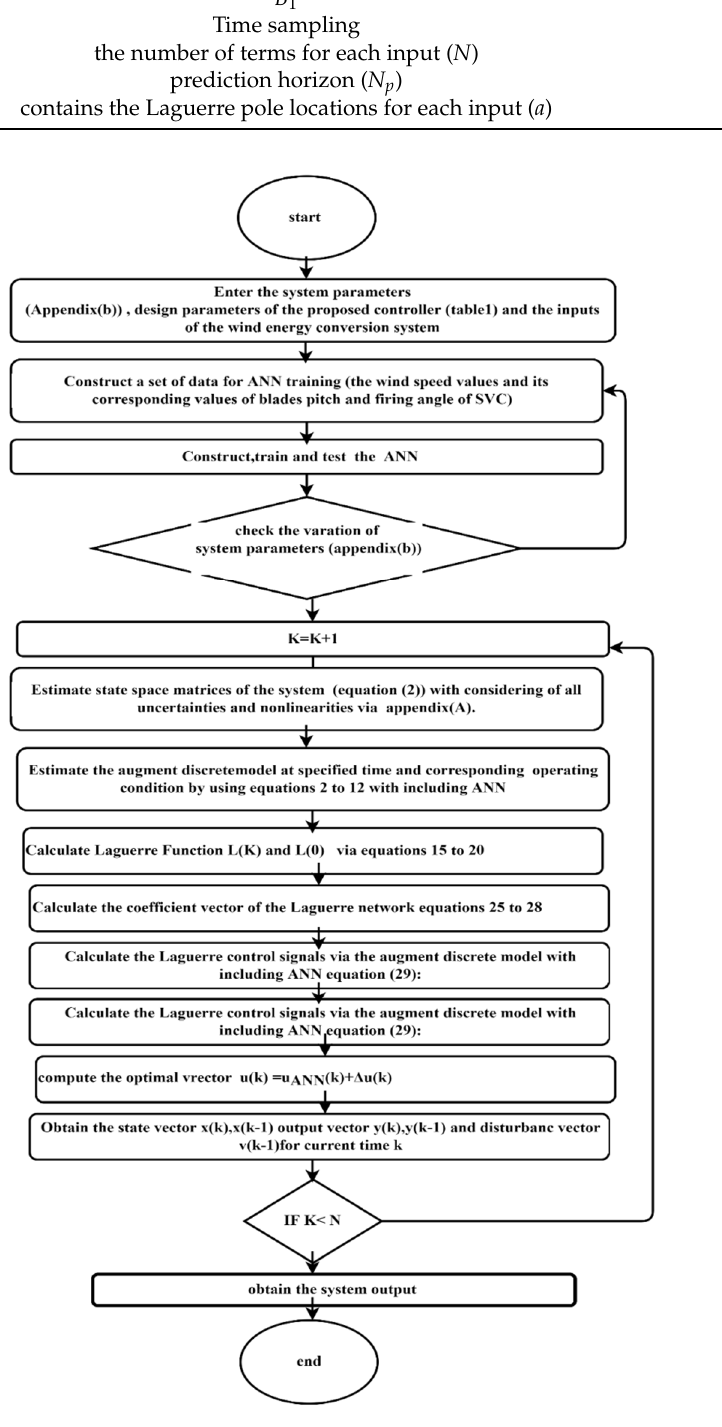
Figure 6. Flowchart of the neuro-predictive control.